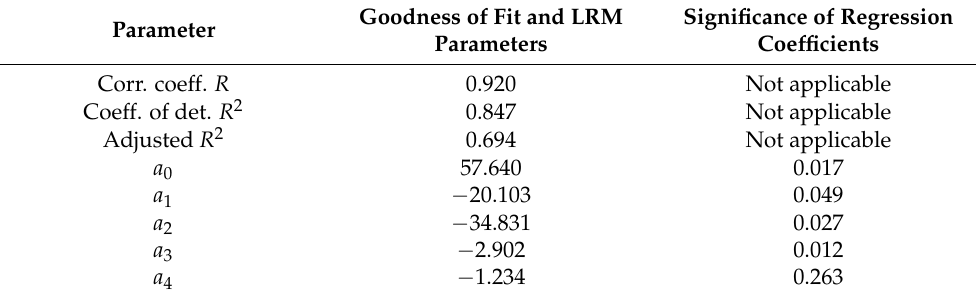
Table 6. Summary of the LRM for the fatigue life of the spruce specimens.